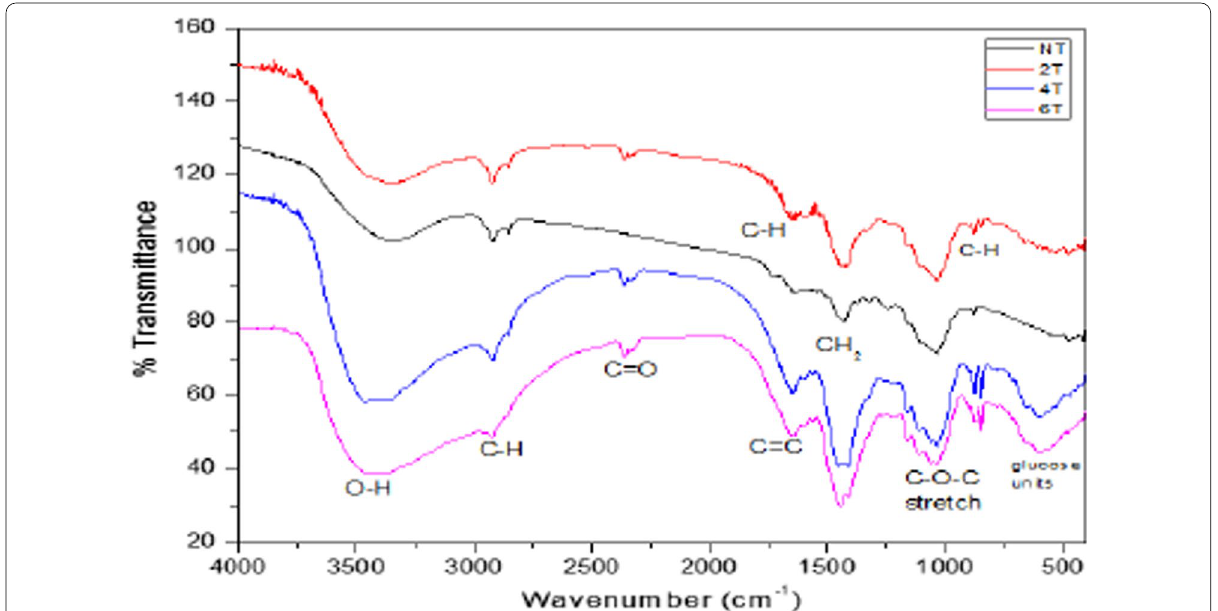
Fig. 1 IR spectra of treated and non-treated plantain fibres (Alavudeen et al.